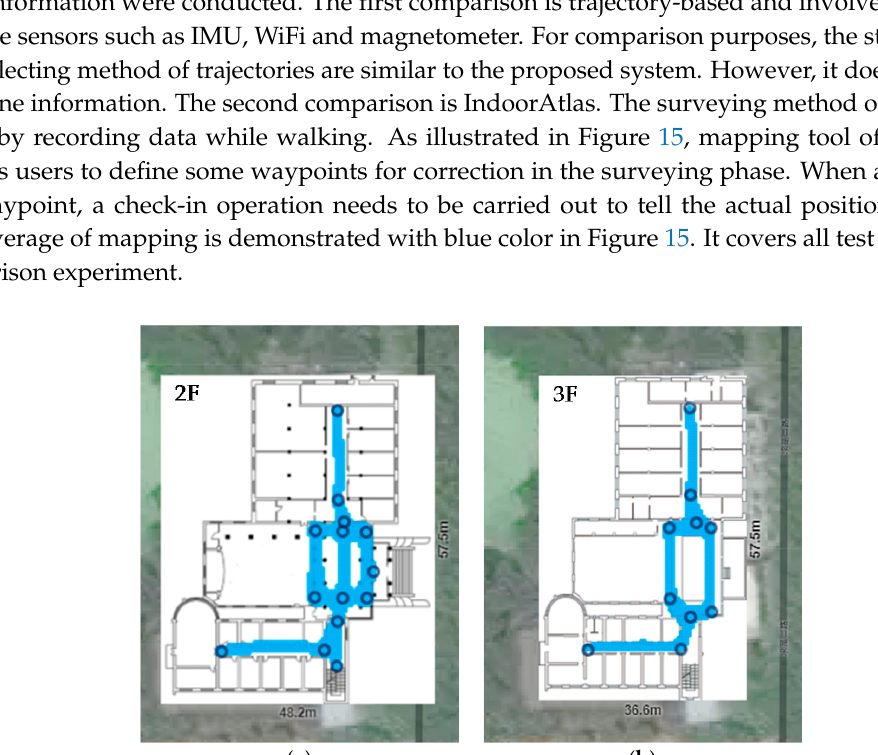
Figure 15. Coverage of site survey on IndoorAtlas. ( a , b ) are survey maps on the second floor and third floors, respectively. The black circles are waypoints we added in this experiment. A waypoint is pinpointed places on a map, and need to be check-in to define the actual position in data recording process.